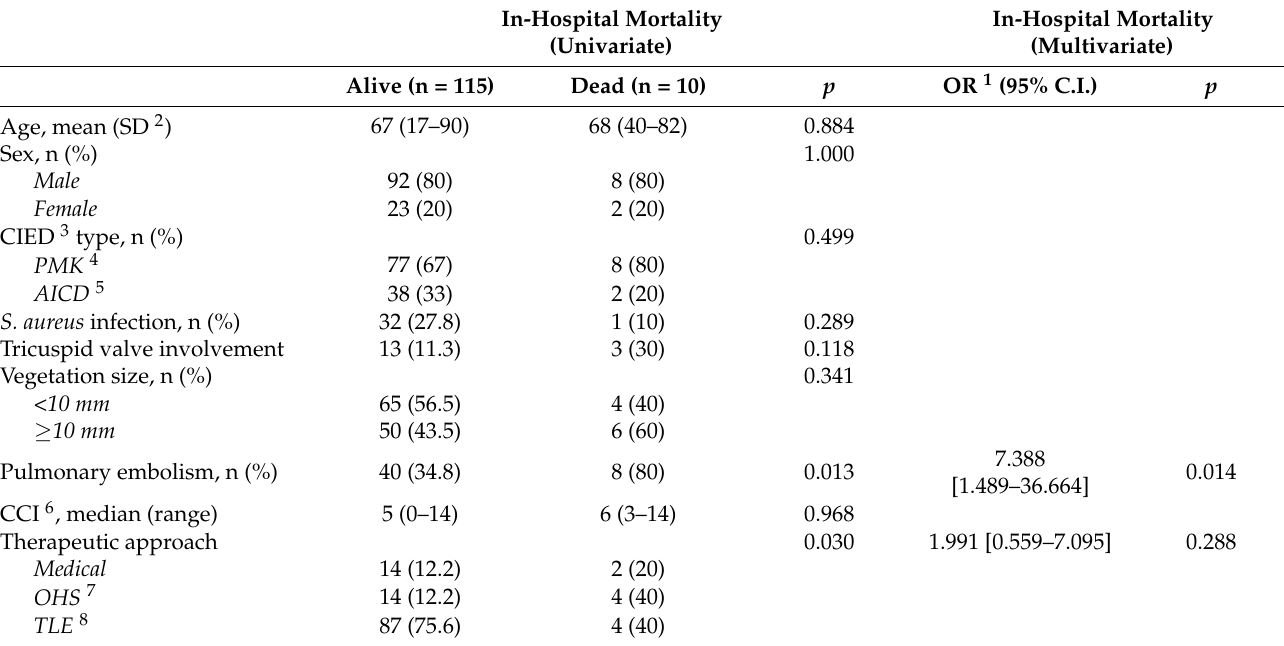
Table 3. Univariate and multivariate analysis of factors associated with in-hospital mortality.